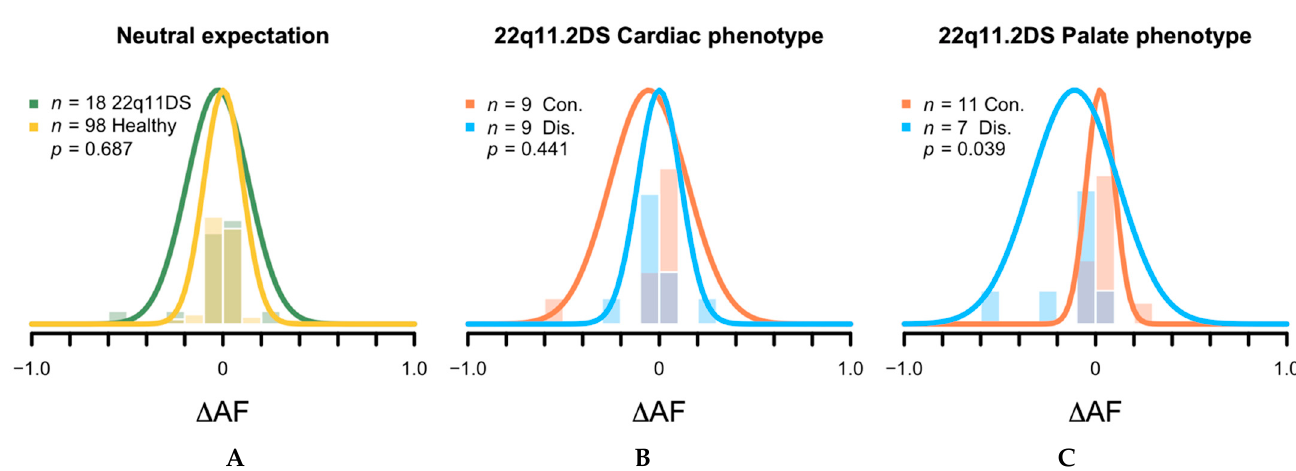
Figure 1. Heteroplasmic allele frequency change ( ∆ AF) between a mother and her child. The histograms describe the actual distribution of the data, whereas the curves represent the expected density distribution provided each sample’s mean and standard deviation. ( A ) Comparison of the distribution of ∆ AF between healthy individuals and 22q11.2DS patients. Comparison of the distribution of ∆ AF between phenotypically concordant and discordant mother-child pairs for the cardiac ( B ) and palatal ( C ) phenotypes. Con, concordant pairs and Dis, discordant pairs.